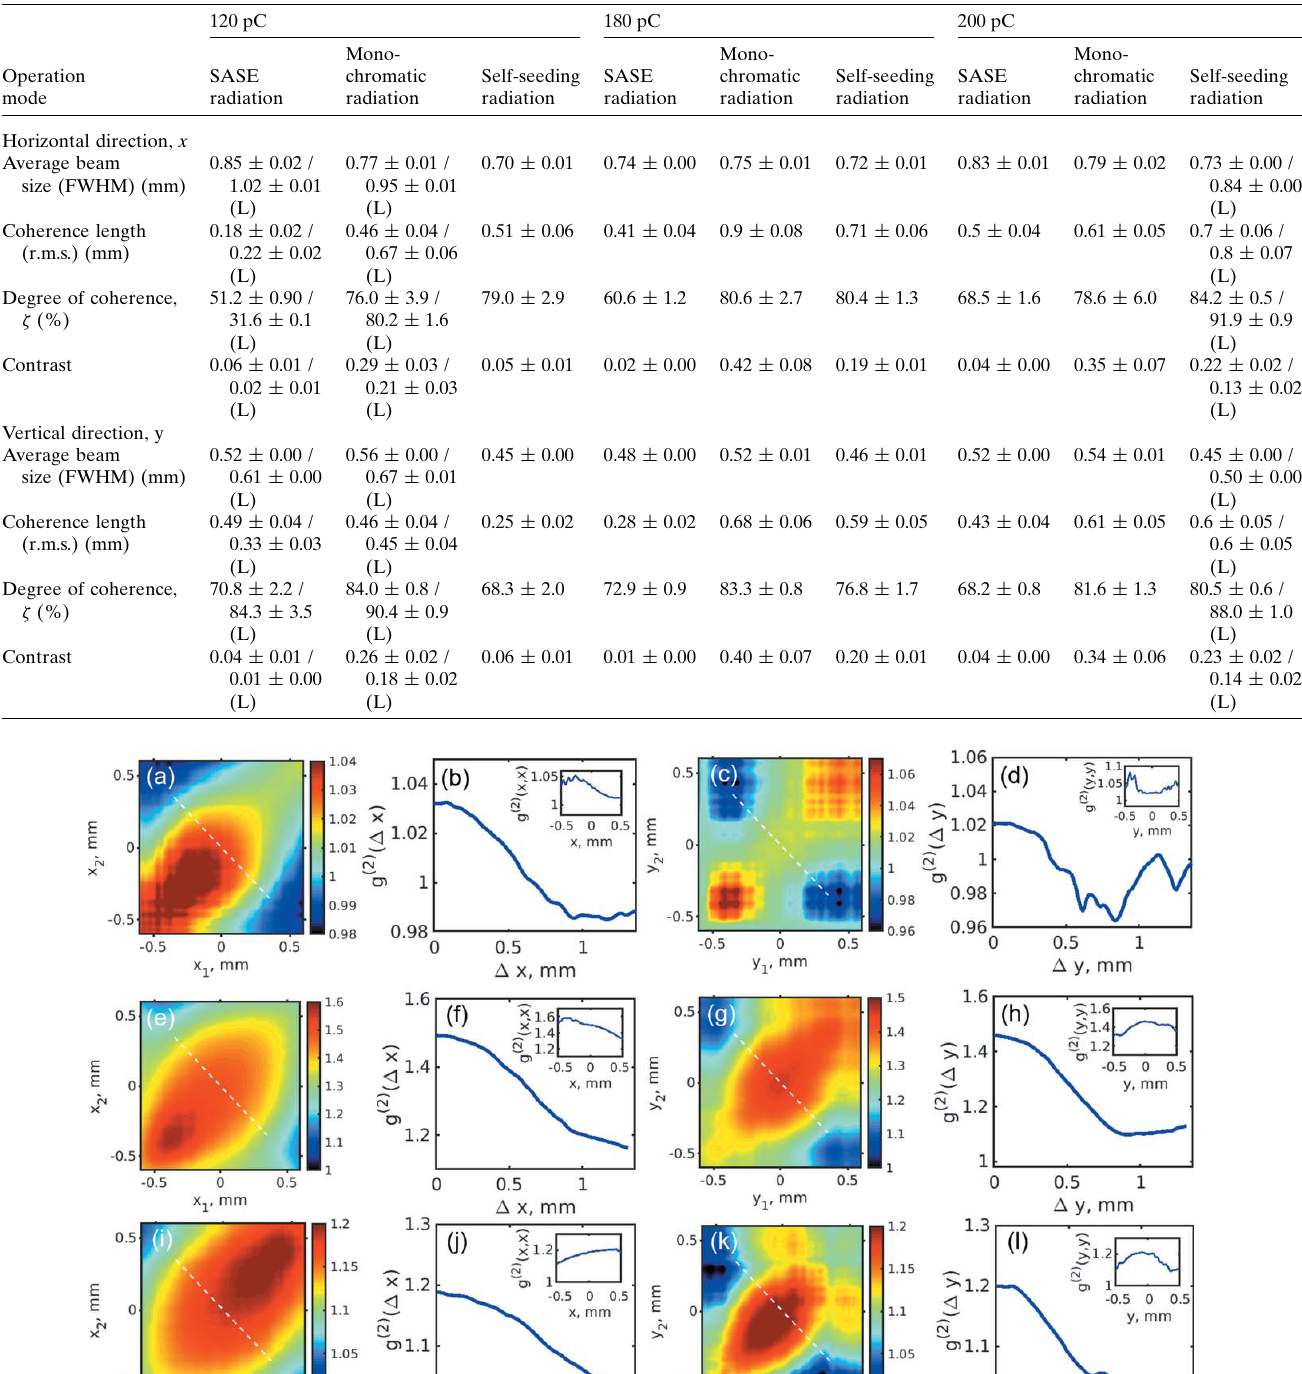
Table 2 Results of the analysis in the spatial domain for the 120, 180 and 200 pC bunch charges used in the experiment. The beam size (FWHM) was determined by the direct evaluation of an averaged intensity distribution. The coherence length L coh was obtained from equation (12) in which integration was performed over the region where g (2) ( (cid:2) r ) (cid:10) 1. The degree of coherence was determined by equation (13) in which integration was performed over the region where g (2) ( (cid:2) r ) (cid:10) 1. The contrast value was defined as (cid:2) 2 ð D ! Þ = g ð 2 Þ ð r ; r Þ (cid:5) 1 at r = 0 in the horizontal and vertical directions, respectively. The values of different parameters measured in the linear mode of operation are also provided.